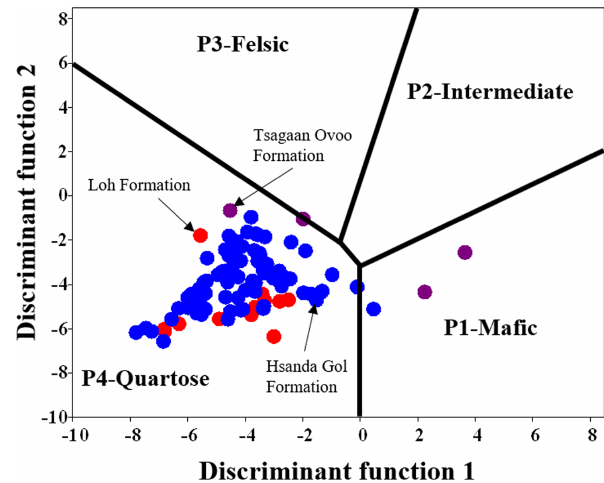
Figure 7. Discrimination plot of discriminant function 1 and 2 in- dicating a narrow provenance range (mainly type P4-quartzose) for the sediments from the Valley of Lakes,